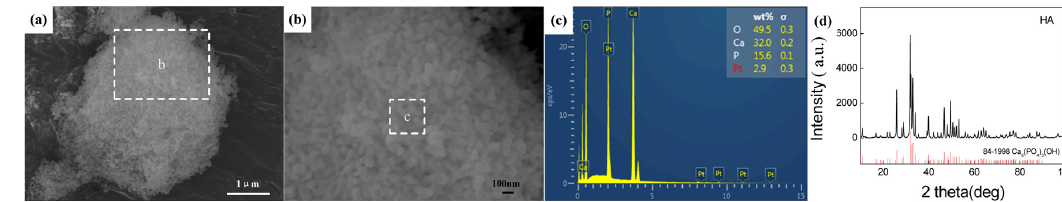
Figure 2. ( a , b ) SEM morphology; ( c ) EDX spectrum, and ( d ) XRD pattern of n-HA powders.